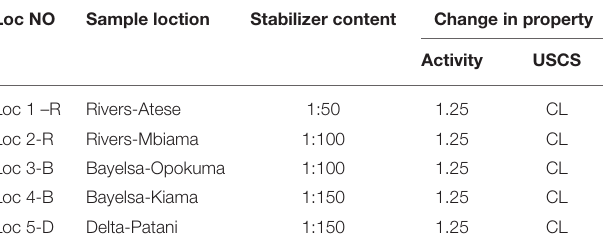
TABLE 10 | Effect of nanomaterial on classification by activity levels (source: analysis of laboratory results). Loc NO Sample